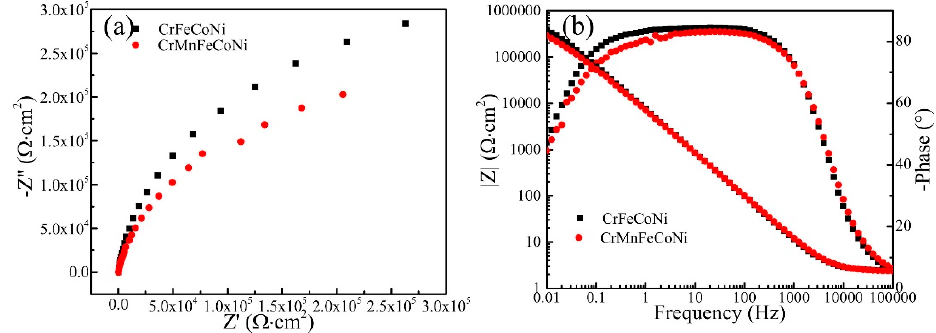
Figure 9. Nyquist diagrams ( a ) and Bode plots ( b ) of the CrFeCoNi and CrMnFeCoNi coating in 3.5 wt% NaCl solution at OCP condition.